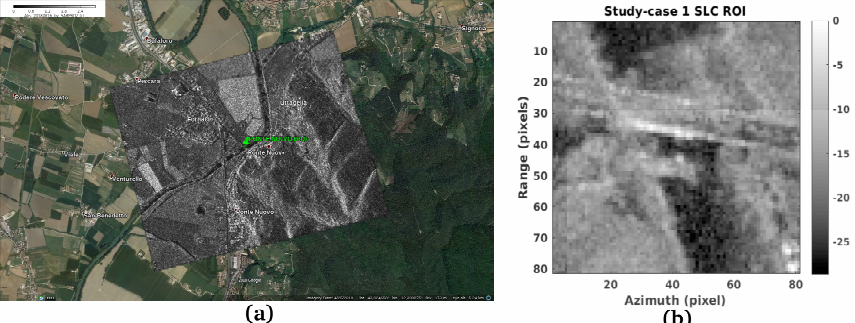
Figure 11. Case study 2 magnitude SAR images. ( a ): Geolocated image with ROI footprint representation. ( b ) Particular of the ROI magnitude in the slant